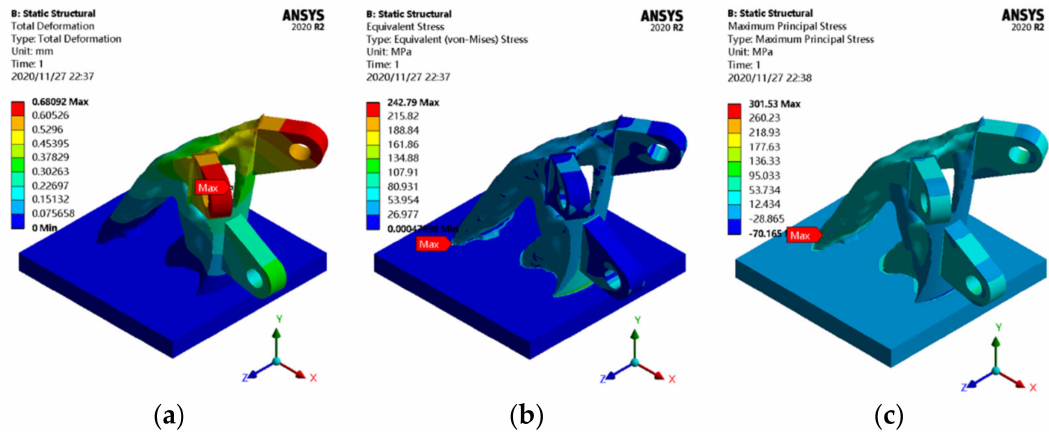
Figure 11. Static analysis results of the smoothing joint: ( a ) displacement cloud map; ( b ) equivalent stress cloud map; ( c ) principal stress cloud